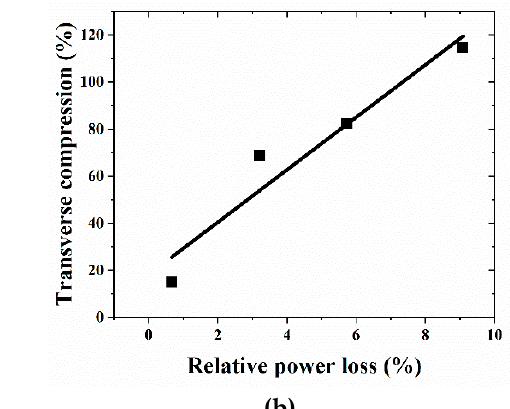
Figure 7. Experimental setup of the strain FBG sensor based on a fixed narrow-band optical filter and a fast photodiode (i.e., power meter).